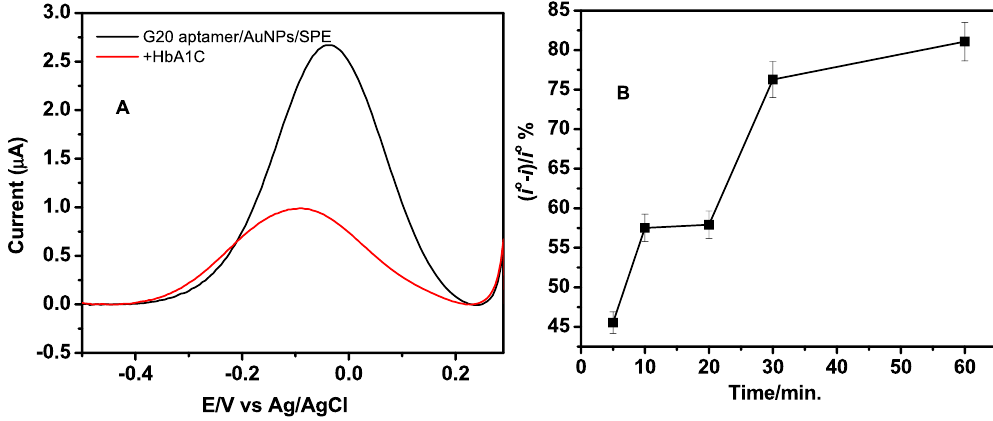
Figure 4. ( A ) Example of square wave voltammetry signal of the aptasensor before (black) and after (red) binding with HbA1c, ( B ) Effect of the binding time on the HbA1c aptasensor response